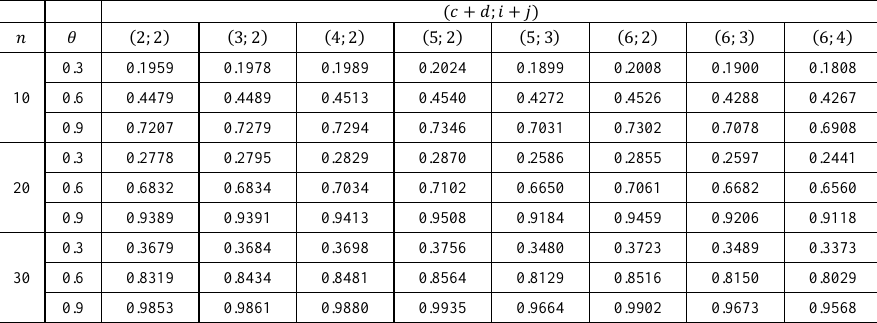
for Normal distribution 𝑐,𝑑;𝑖,𝑗